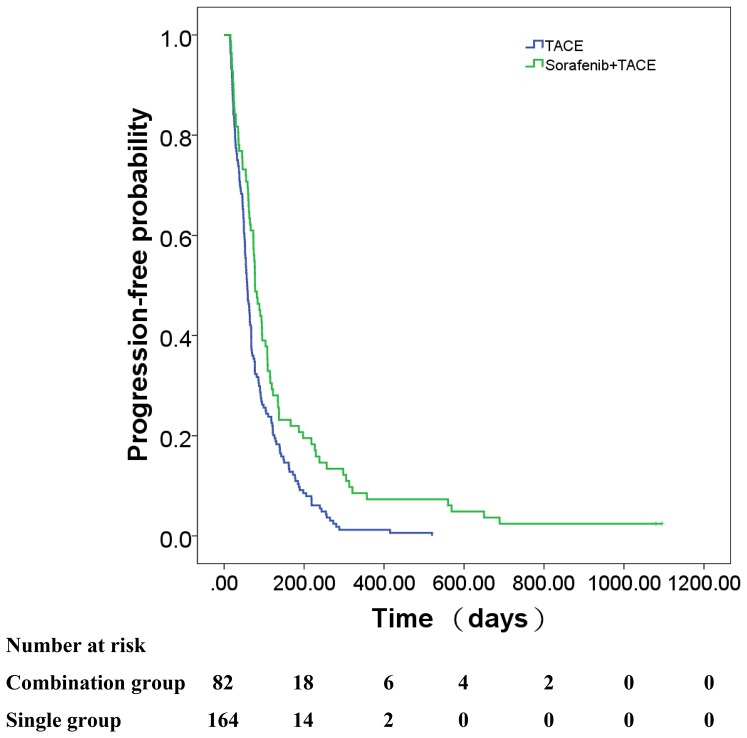
Kaplan–Meier analysis of TTP in the combined and monotherapy groups of propensity-matched patients.Median TTP of the combined group was significantly longer compared with the monotherapy group in the matched model (2.6 months vs 1.9 months, respectively; P  =  0.001).